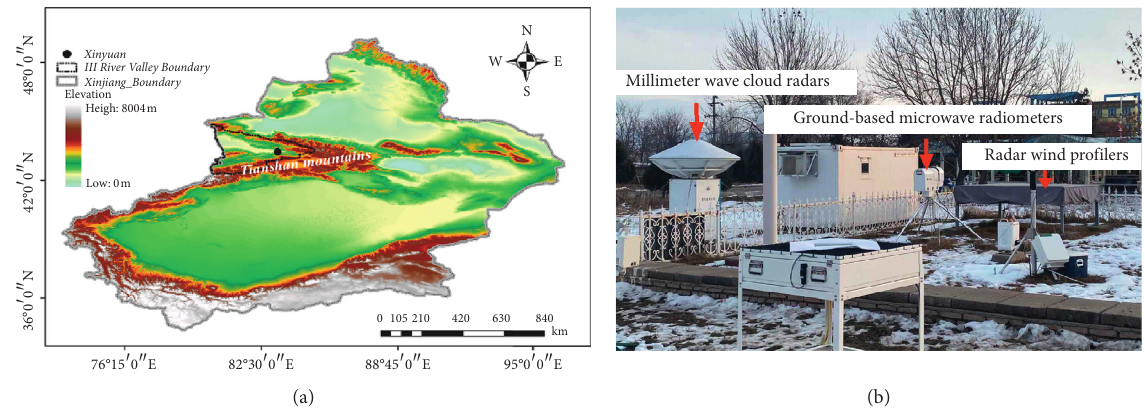
Figure 1: (a) The location of the test area in Xinjiang. (b) Photograph of the test